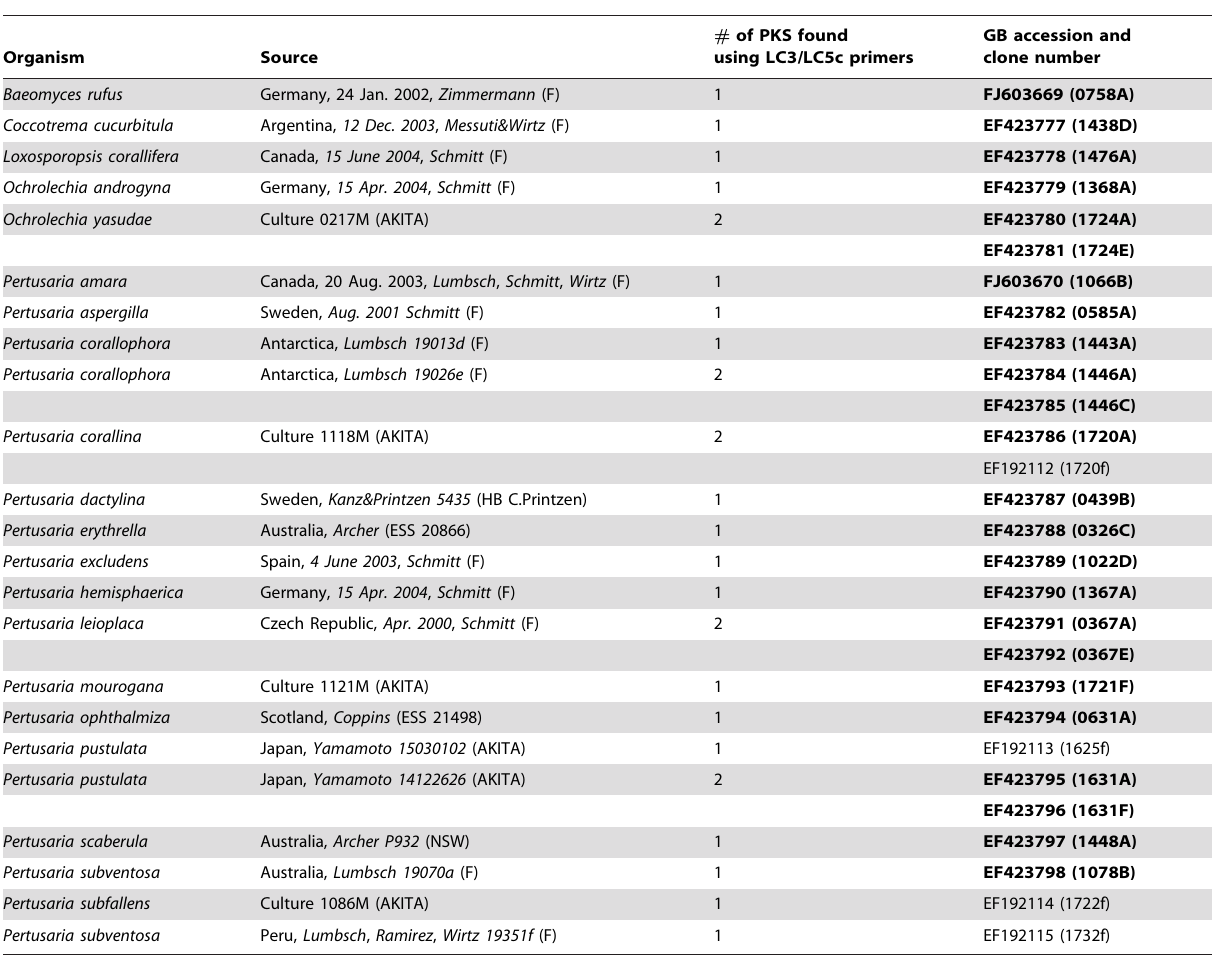
Table 1. Lichenized fungi used in this study. New sequences are indicated in